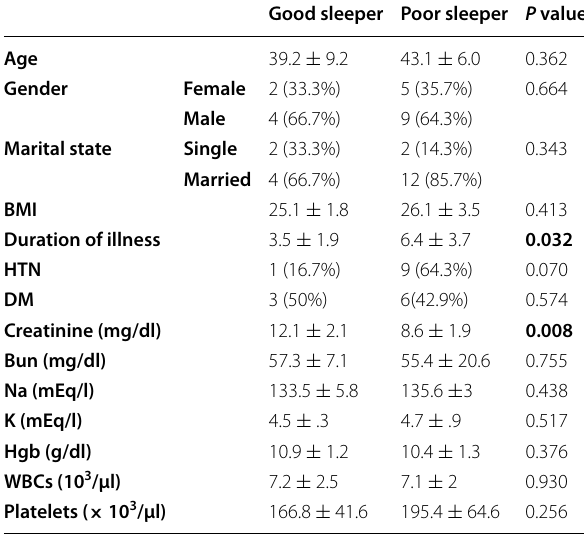
Values are expressed as number (%) or as mean